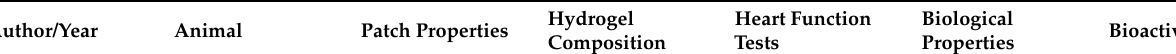
Table 1. The studies on hydrogel-based cardiac patches in cardiac repair and regeneration after MI in recent